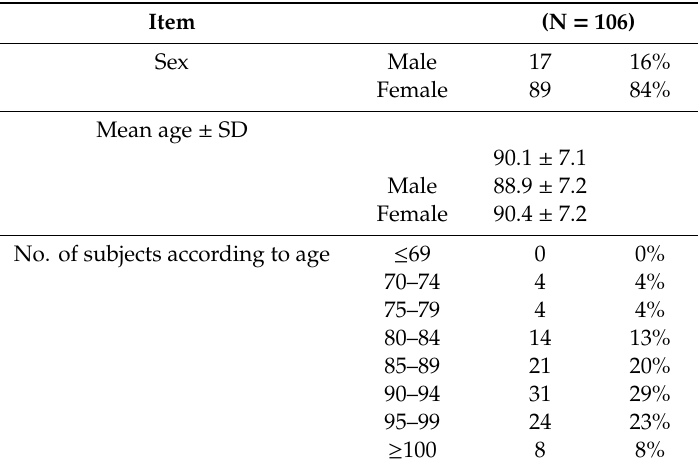
Table 1. Patients characteristics.